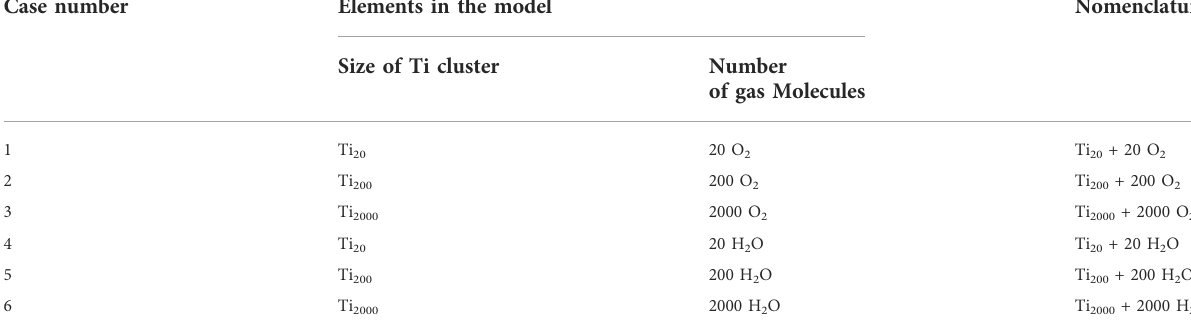
TABLE 2 The six models designed to study the anti-oxidation and anti-hydrogenation mechanisms of Ti clusters of varying